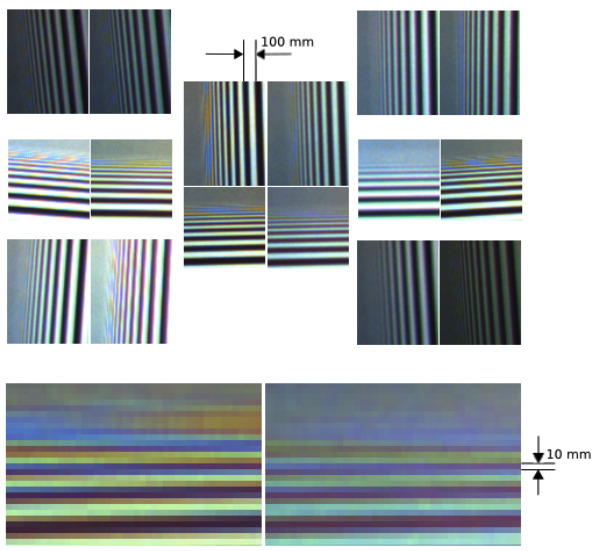
Figure 3: Resolution comparison between the 5M and the 3M lenses using the images of a resolution testing board taken from a distance of 100 m.